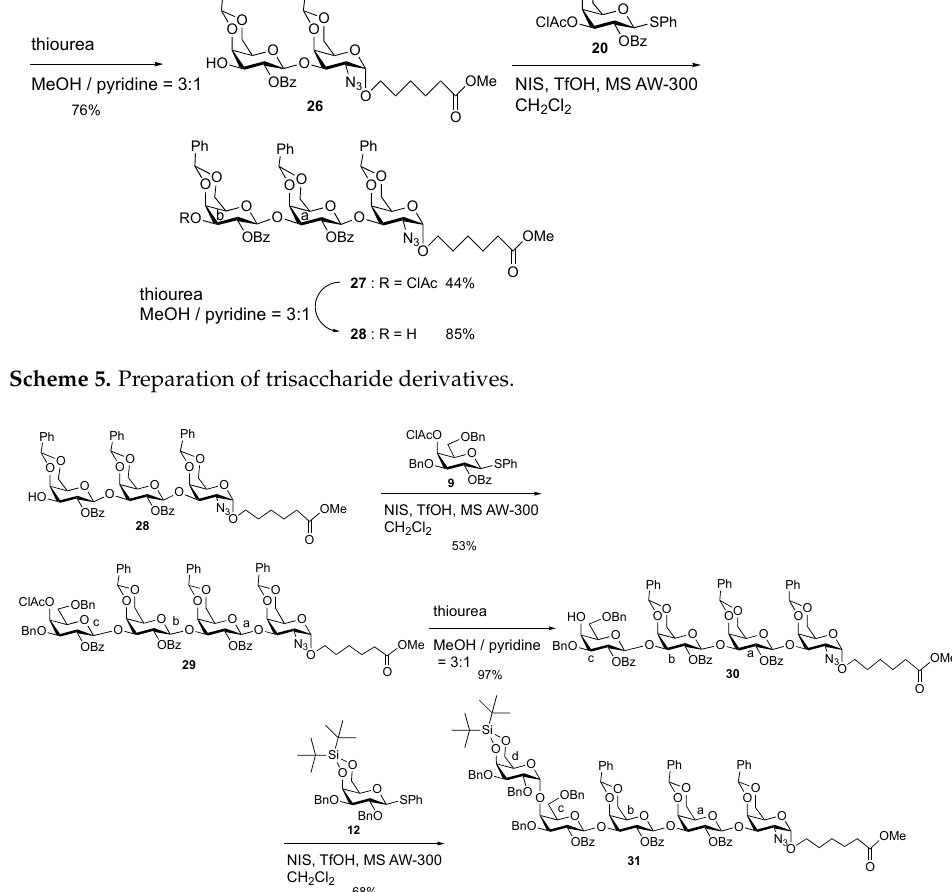
Scheme 6. Preparation of pentasaccharide derivative 31 .